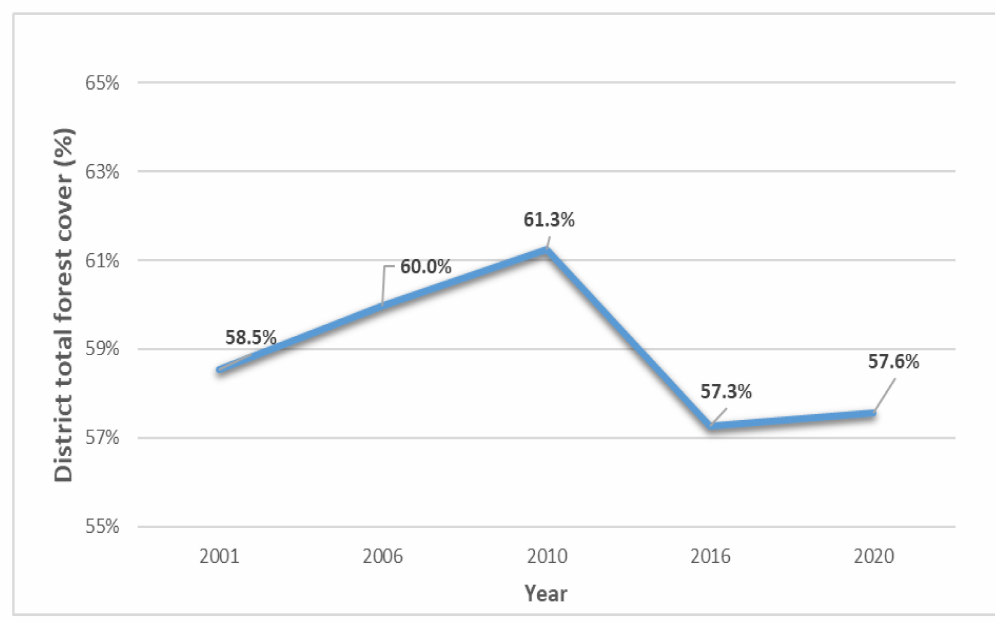
Figure 4. Overall trend in forest cover change in the study